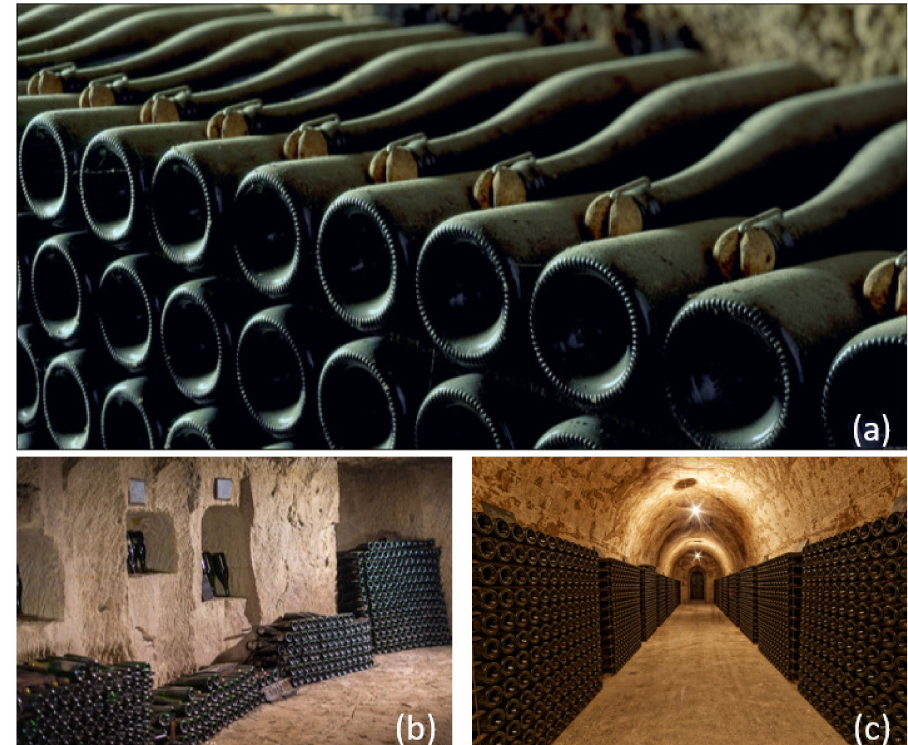
Figure 1. ( a ) Bottles of Champagne hermetically sealed with a natural cork and stacked horizontally in the course of their prise de mousse , followed by a long period of ageing on lees (Collection CIVC). Cr é mant de Loire and Champagne undergoing their prise de mousse in cellars ( b ) from the Loire area (Gratien et Meyer) and ( c ) from the Champagne area (Emmanuel